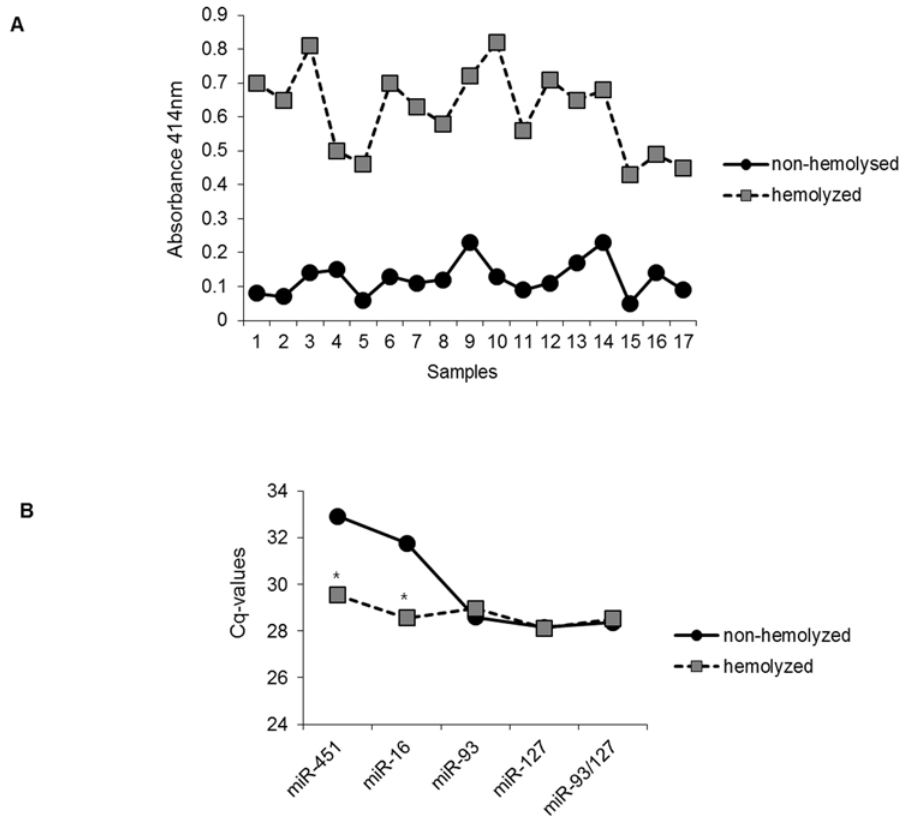
Fig 4. Evaluation of potential reference miRNAs in hemolyzed bovine serum. (A) The absorbance values at 414nm of hemolyzed and non-hemolyzed serum were measured to determine levels of free hemoglobin. (B) Levels of miR-16, miR-451, miR-93, miR-127, and the combination miR-93/miR-127 were measured in a cohort of non-hemolyzed samples (circles, n = 17) and hemolyzed samples (squares, n = 17). Statistical analysis was performed using Student ’ s t -test. * p <